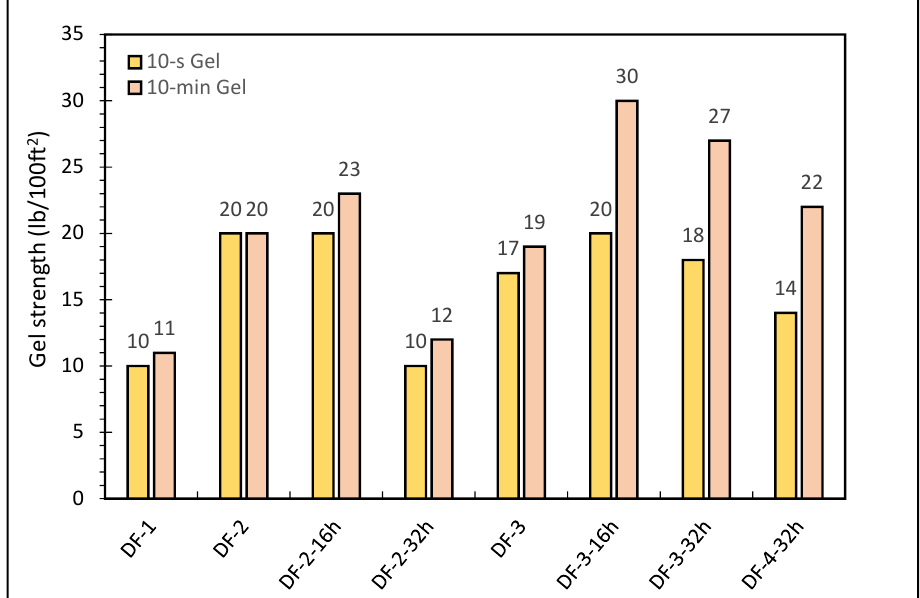
Figure 4. The gel strengths of oil-based drilling fluids .